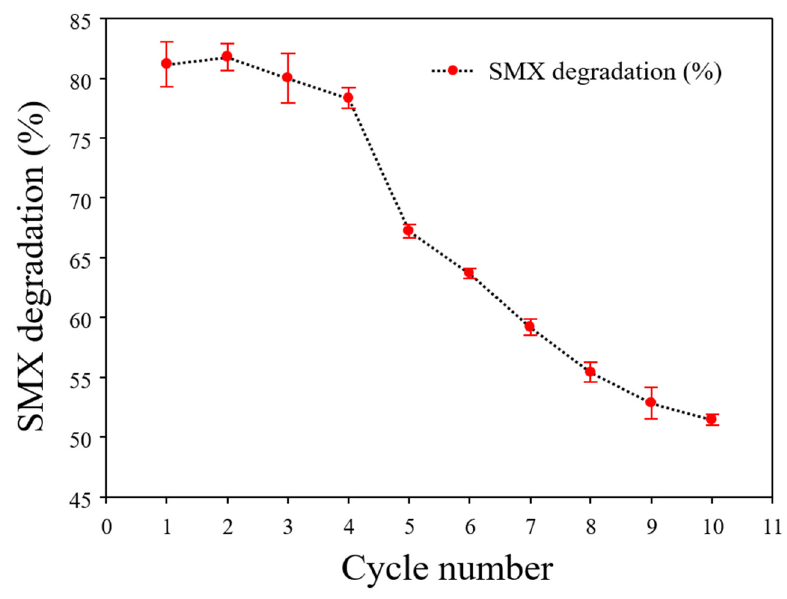
Figure 10. The repeated cycle degradation of SMX by α -Cellulose-Fe 3 O 4 -CTNs-SH-Laccase.